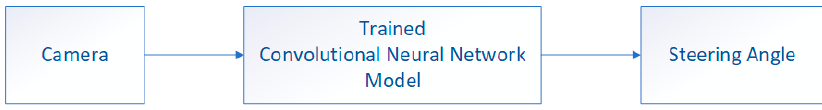
Figure 2. Block diagram of an end-to-end autonomous driving system.